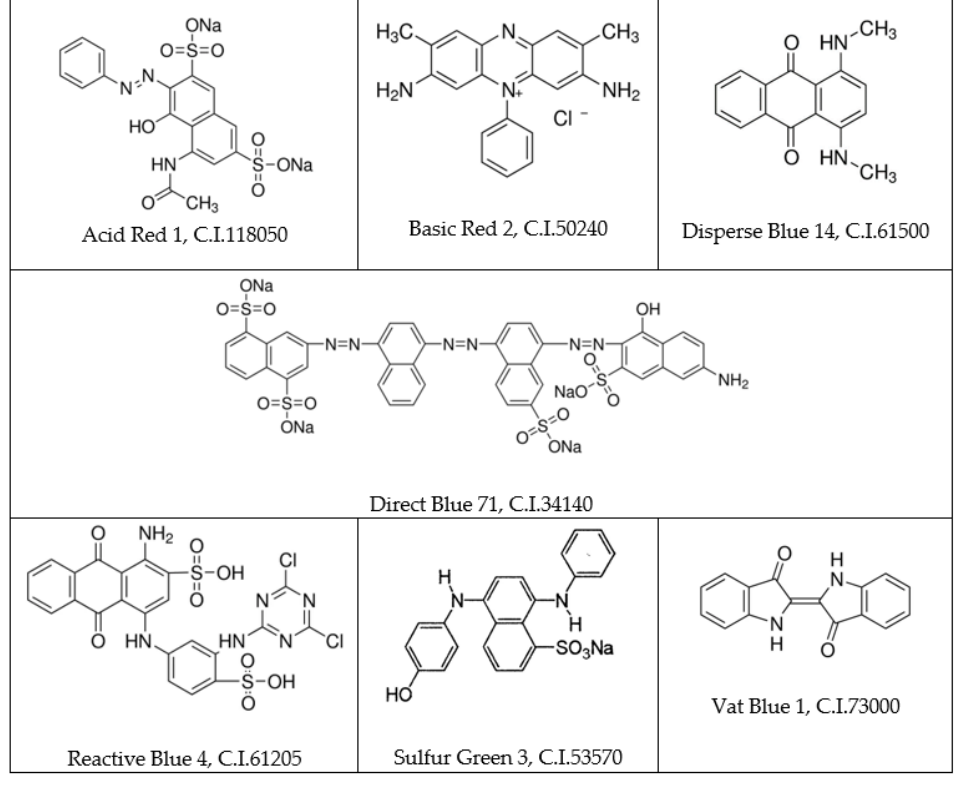
Figure 1. The exemplary molecular structure of dye form various groups: acidic, basic, direct, disperse, reactive, sulfur, and vat. Table 1. Groups of dyes and types of fibers dyed by them.